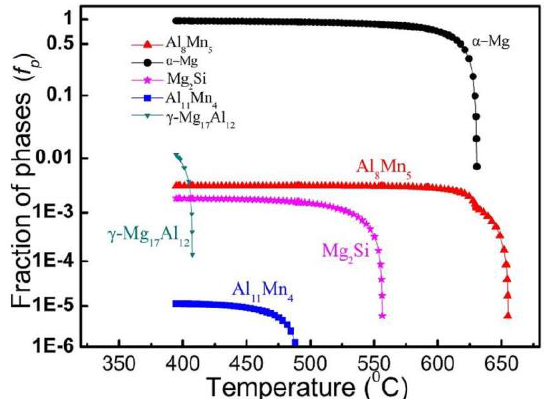
Figure 3. Precipitation sequence and molar fractions of all solidified phases during the non-equilibrium solidification of the AZ31 alloy.